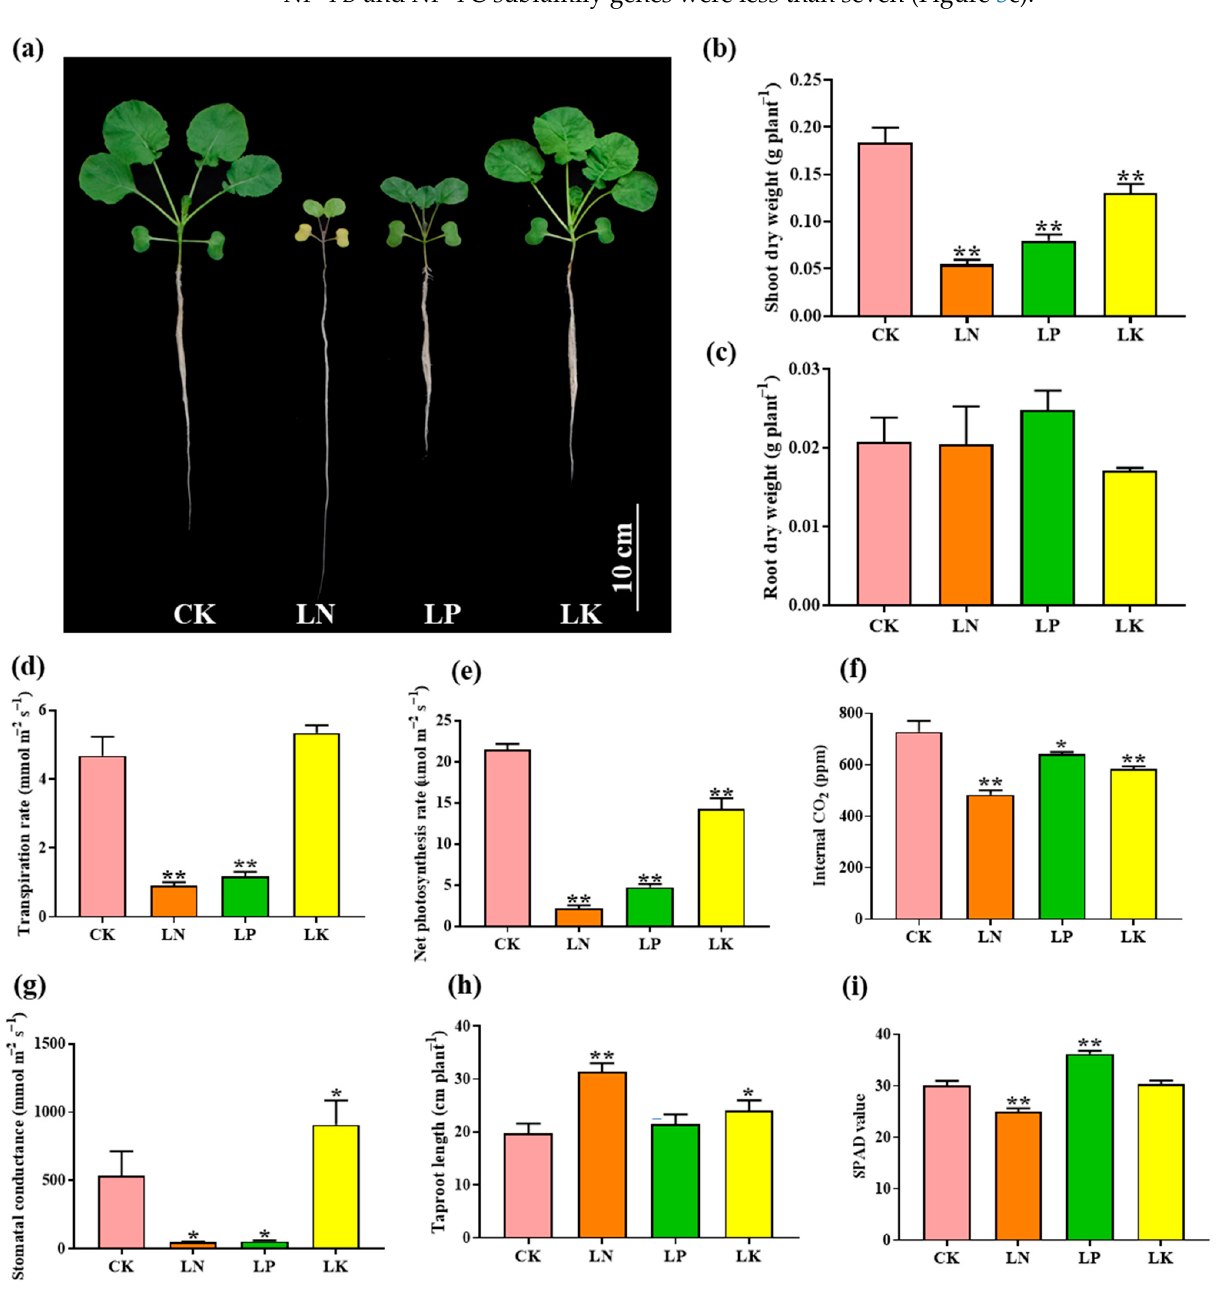
Figure 1. The physiological responses of B. napus to N, P and K deficiencies. ( a ) The phenotypes of B. napus under N, P and K deficiencies; ( b ) Shoot dry weight; ( c ) Root dry weight; ( d ) Transpiration rate; ( e ) Net photosynthesis rate; ( f ) Internal CO 2 ; ( g ) Stomatal conductance; ( h ) Taproot length; ( i ) SPAD value. CK: normal nutrient supply; LN: N deficiency (100 µ M N); LP: P deficiency (5 µ M P); LK: K deficiency (5 µ M K). Error line represents variance ( n = 4), different letters ( a – d ) indicate significant differences per Student’s t test, * p < 0.05, ** p < 0.01. The gene ID, gene length (coding sequence), gene location, intron number, protein